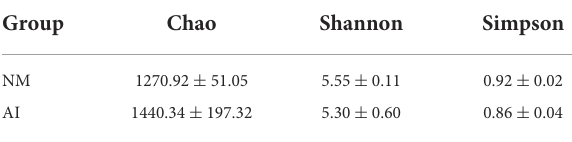
TABLE 2 Comparison of α diversity parameters between the NM group and AI